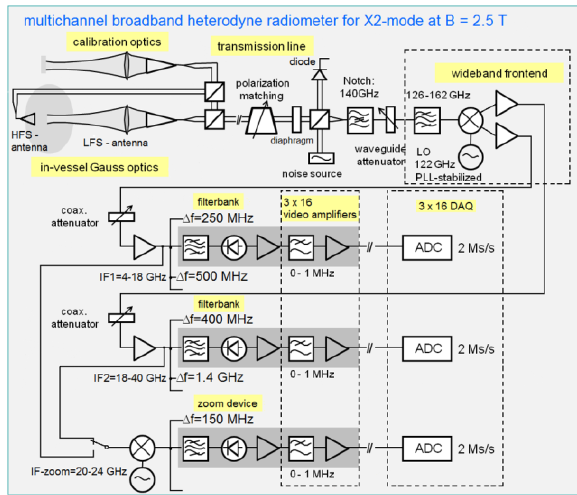
Fig. 5: Scheme of the 32ch radiometer and the 16ch zoom device.